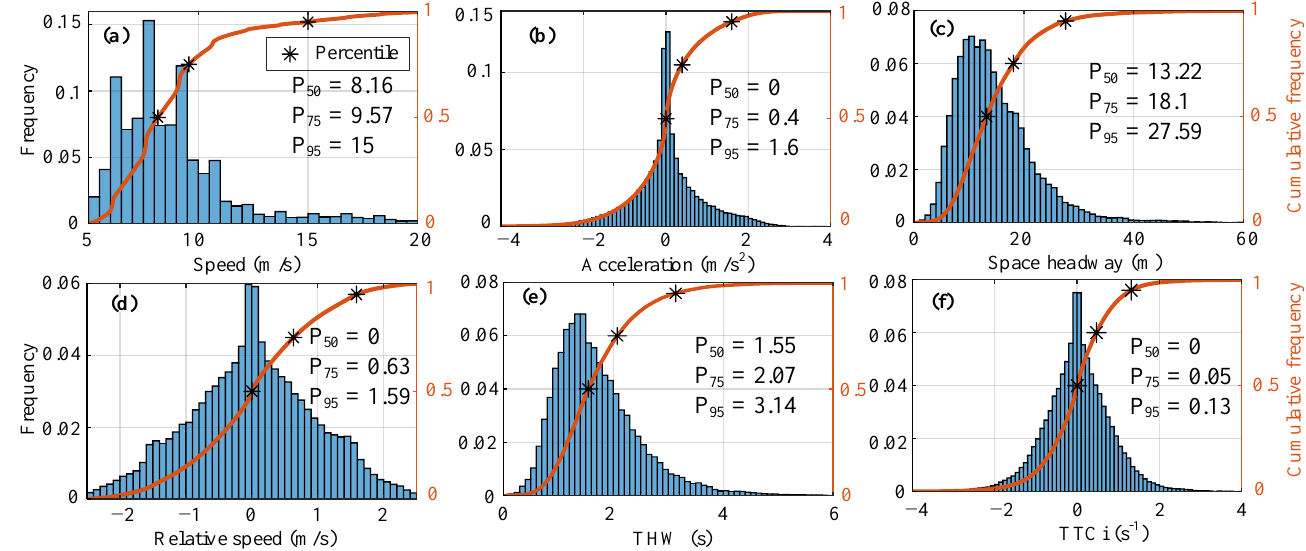
Figure 1. Empirical distribution of characteristic parameters in car-following events, where ( a – f ) respectively correspond to the following vehicle speed and acceleration, space headway, relative speed, time headway, and inverse time to collision.